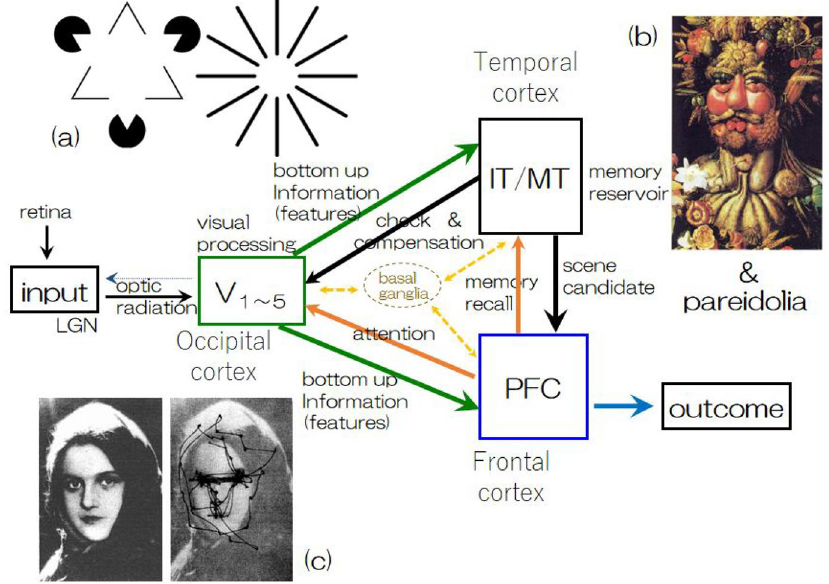
Figure 2. A three-module model of visual processing that enables veridical perception. ( a ) A well-known illusion that shows a representative example of compensation resulting from the subconscious interaction between the visual cortex and temporal cortex. ( b ) A figure painted by Giuseppe Arcimboldo in 1591 called Vertumnus, porträttet av Rudolf II , which induces a typical subconscious function of memory recall of parts, one by one (vegetable & fruits, etc.), and empirical imaging of the entire scene or context in the mind. Portions were omitted to show image examples of “pareidolia”. ( c ) A typical example of attentional eye movement reported by A. L. Yarbus (1967) driven by top-down information transmitted from the frontal cortex. The basal ganglia regulate and adjust the functional activities of all fields (cortices) by means of fine control of the inhomogeneous release of neuromodulators